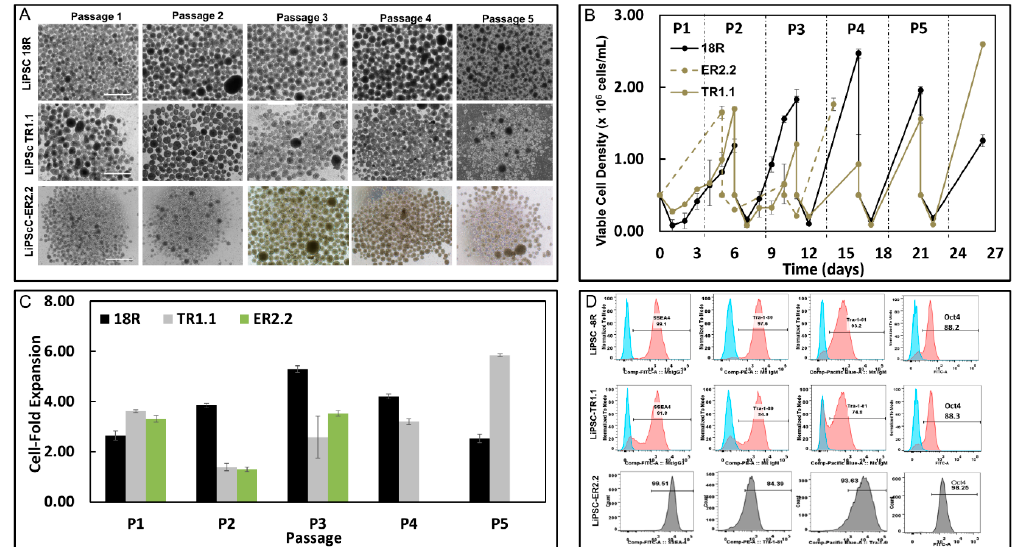
Figure 5. All three cGMP compliant LiPSCs lines were expanded in 3D suspension culture environment while maintaining their pluripotency. ( A ) Photomicrograph of the human PSCs (hPSCs) in 3D suspension culture during five passages in the Biott bioreactor. ( B ) Viable cell density during five pasages in Biott suspension bioreactors. ( C ) Three lines showed different cell-fold expansion during 3D culture. ( D ) All three lines demonstrated a high level of pluripotency specific markers: SSEA4, Tra-1-81, Tra-1-60, and Oct4 post expansion in the Biott bioreactor. Scale bars, 100 µm.